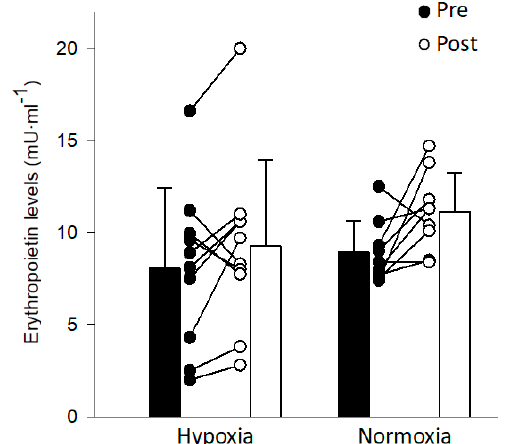
Figure 1. Average and individual erythropoietin levels before (pre; black bars) and 2 hours following the end (post; white bars) of an intermittent hypoxia and intermittent normoxia protocol.